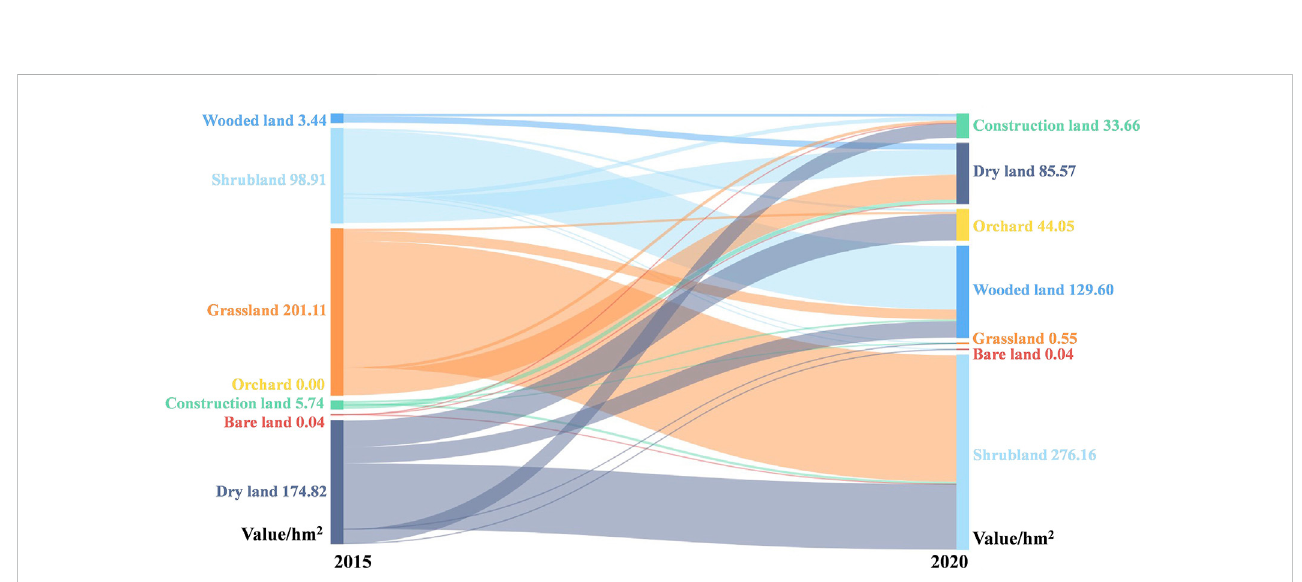
FIGURE 3 Land use transfer Sankey map 2015 –